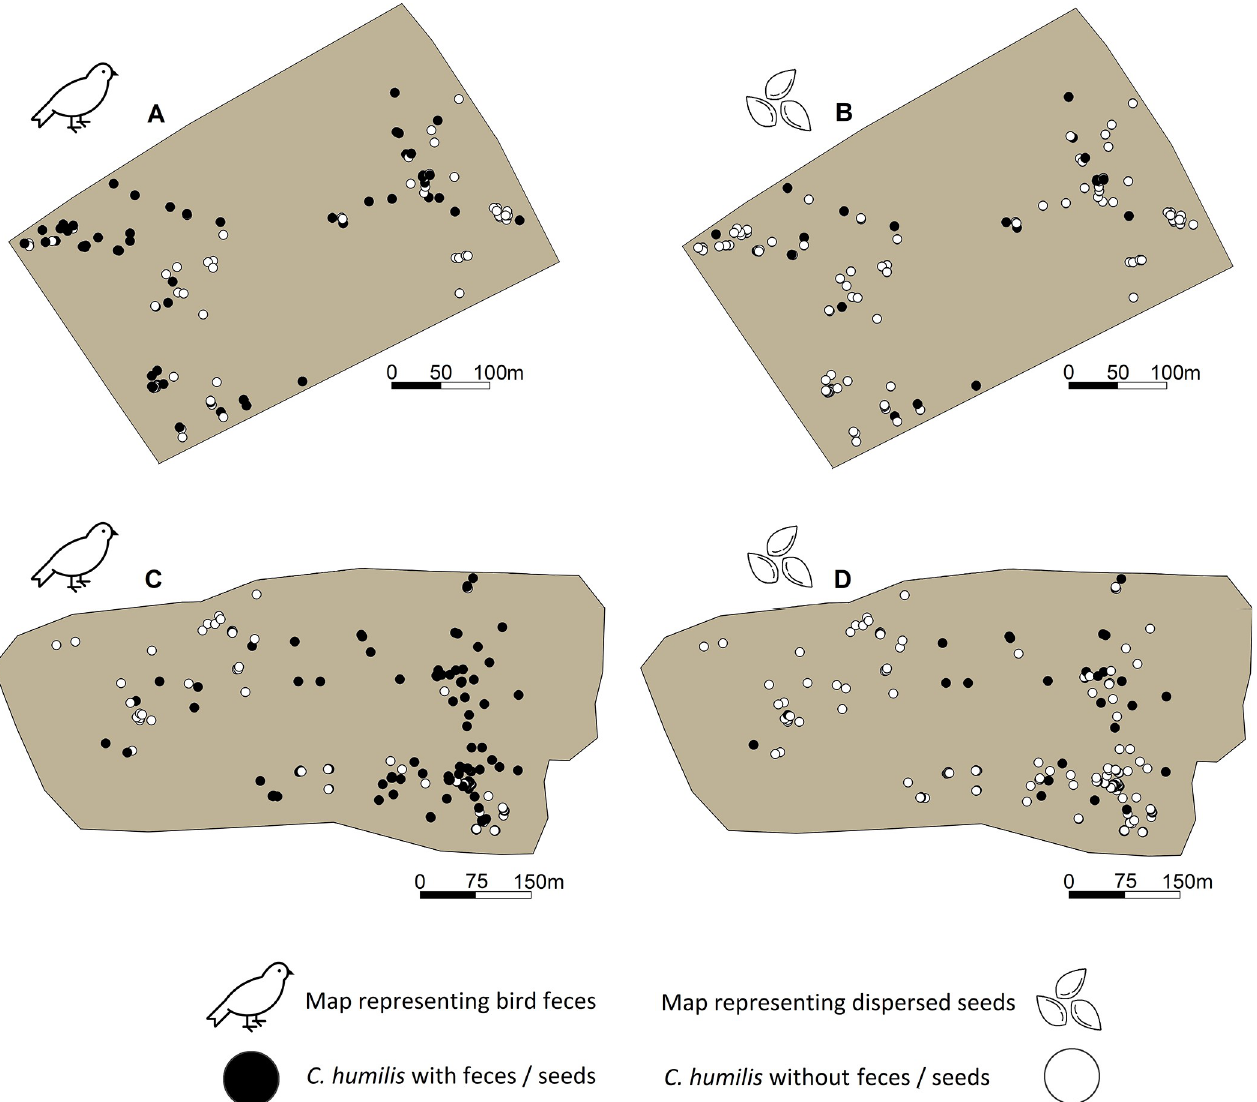
Fig 4. Distribution of C . humilis in the early-successional plot (upper) and the late-successional plot (lower) plots. (A) C . humilis in the early-successional plot with (black solid points) and without (white circles) bird feces or regurgitations. (B) C . humilis in the early-successional plot with (black solid points) and without (white circles) dispersed seeds. (C) C . humilis in the late-successional plot with (black solid points) and without (white circles) bird feces. (D) C . humilis in the late-successional plot with (black solid points) and without (white circles) dispersed seeds. statistics were within the envelops generated by random labelling models, which indicates they are compatible with the stochasticity of the process model. On the contrary, in the late-successional plot, the probability that two C . humilis separated for distances 1-6m, both having feces (p ( r ) statistic), was lower than the expectation under 11 random labelling. The bivariate p ( r ) showed that C . humilis with and without feces were fur- 12 ther away than expected under random labelling up to scales of 6m (Fig 5D). Finally, the den- sity of neighbouring C . humilis (having or not feces) around C . humilis with feces was significantly lower than expected by random labelling for distances up to scales of 7m (Fig 5F).